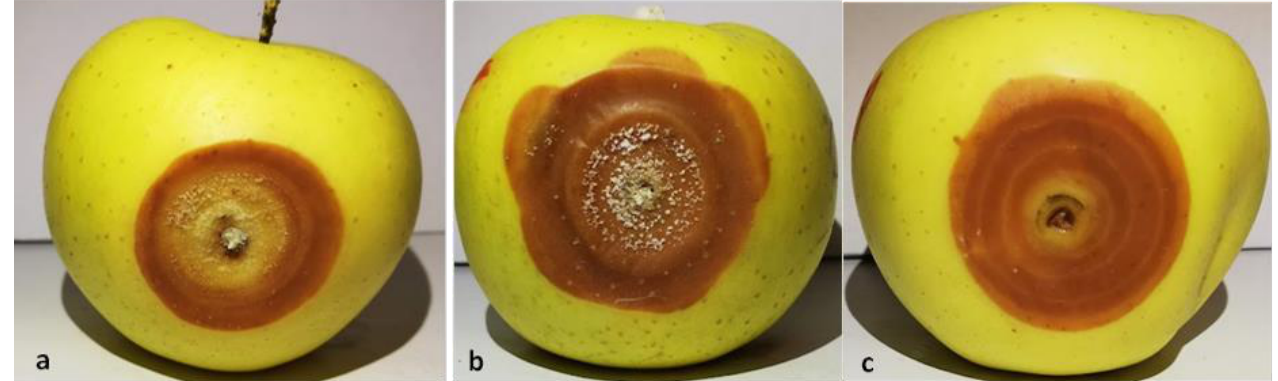
Figure 2. Different decay symptoms on apple fruit inoculated with Neofabraea sp. after incubation of 35 days at room temperature: ( a ) Isolate J129 — lesion with yellowish center and brownish margins; ( b ) Isolate J96/2 — brownish lesion; and ( c ) Isolate J108/2 — brownish lesion with concentric circles.